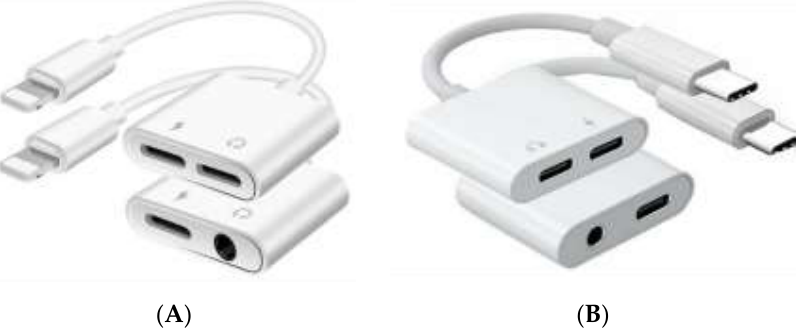
Figure 8. Samples of multifunctional splitter adapters for simultaneous connection of headphones with a standard 3.5 mm jack and charging the device. ( A ) For IOS operating systems. ( B ) For Android operating systems.